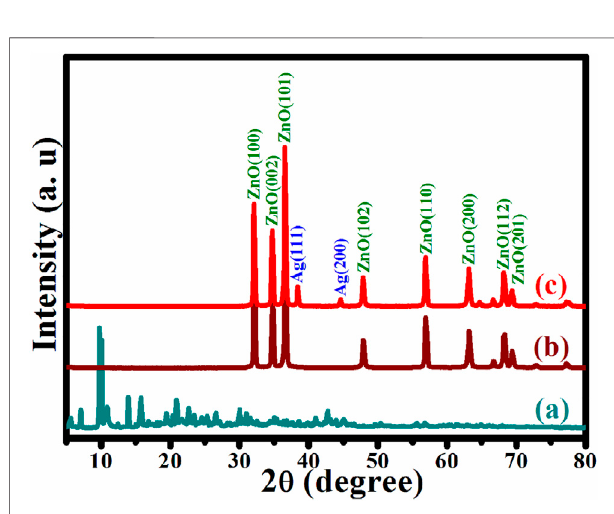
FIGURE 2 | XRD patterns of (A) MIL-125(Zn), (B) ZnO, and (C) Ag/ZnO.